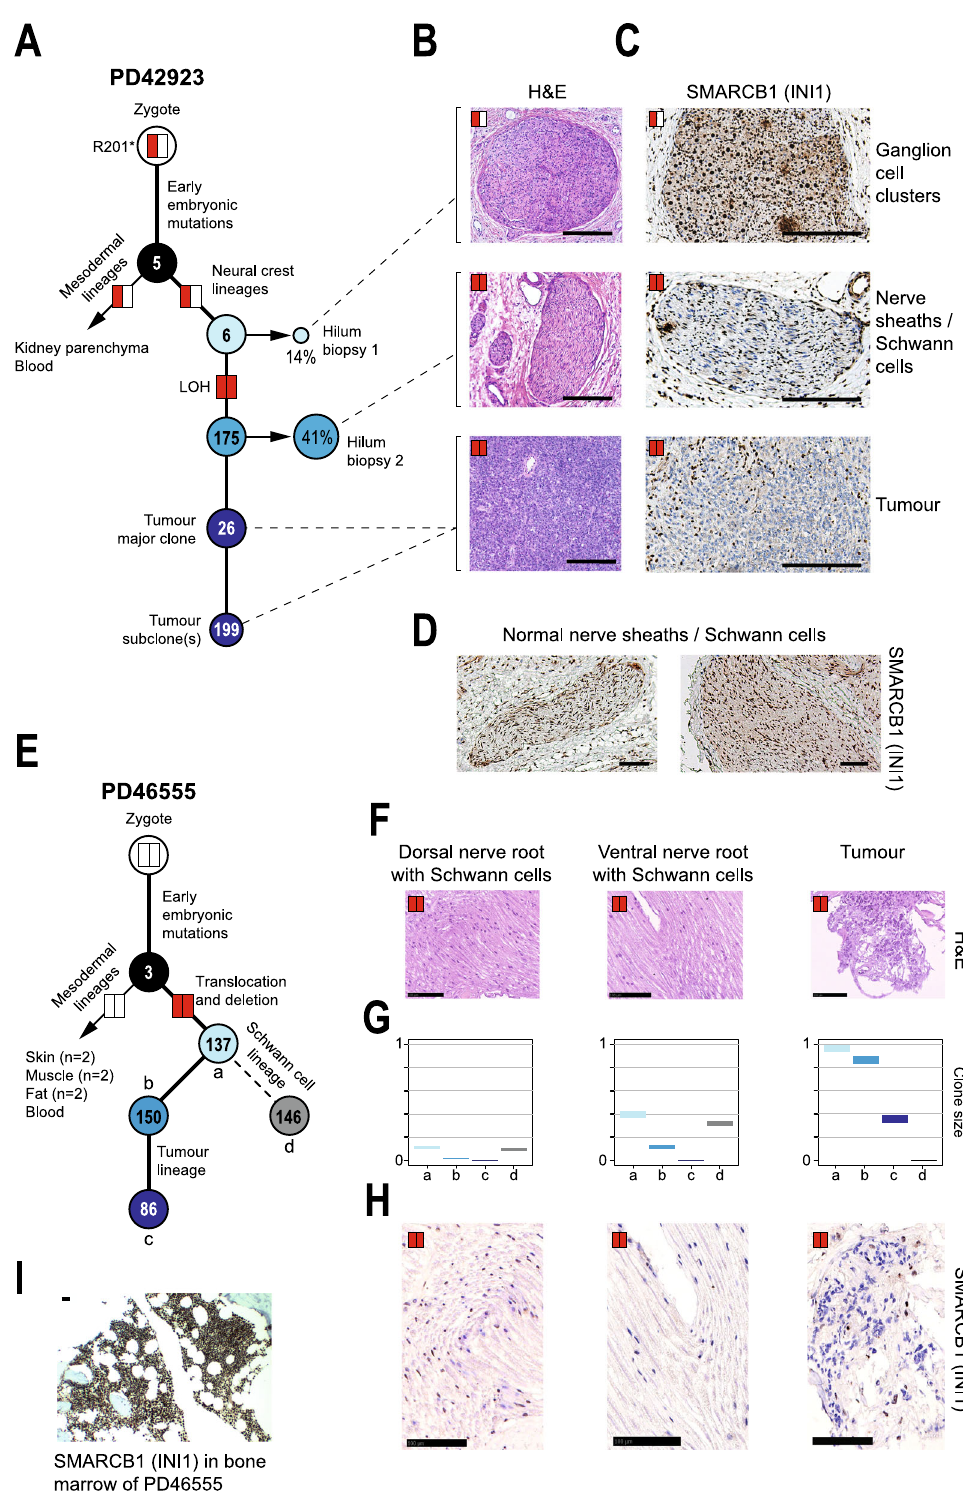
(Fig. 2b, Supplementary Fig. 4a, c). While both 60T and 103T transformed from a grape-like to a neural- or fi broblast-like morphology with long extensions protruding from the cell body, 78T stopped proliferating without an apparent mor- phological change. To assess the transcriptional pro fi les underpinning these phenotypic changes, we subjected